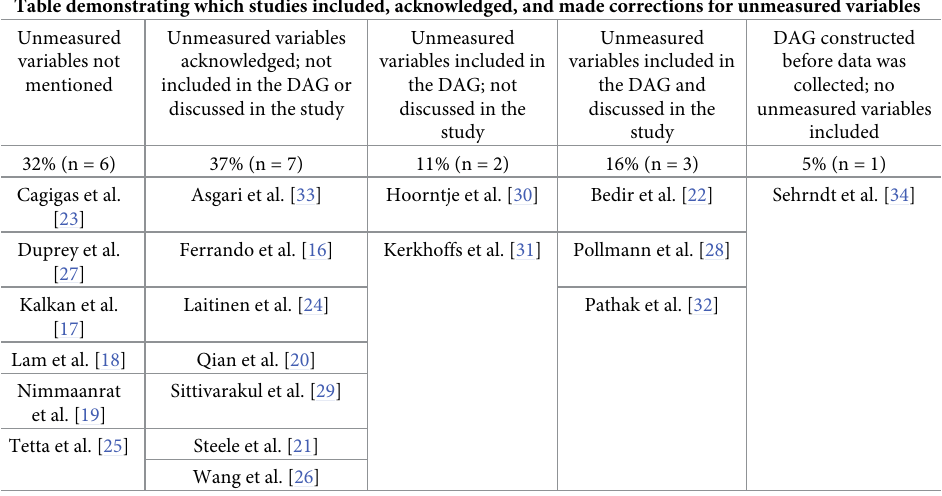
Table 4. Table demonstrating the extent to which different studies dealt with unmeasured variables, if at all. Table demonstrating which studies included, acknowledged, and made corrections for unmeasured